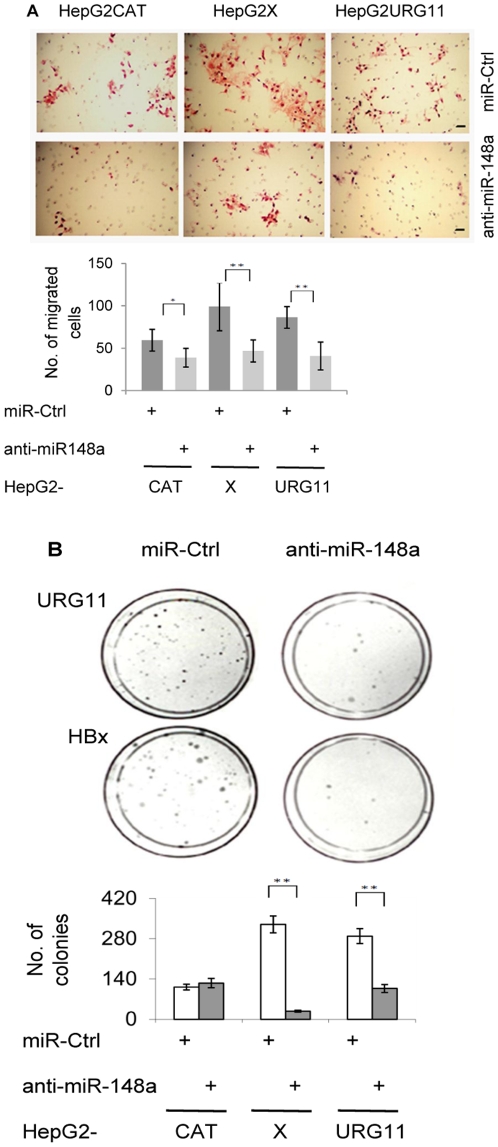
Effect of anti-miR148a on cell migration and anchorage independent growth.(A) Migration of HepG2CAT, HepG2X, and HepG2URG11 cells stably expressing anti-miR-148a or control anti-miR. The top portion of this panel shows the results of a single experiment, while the graphical representation below is the average from 3 independent experiments. The black bar in the photomicrographs is 50um. (B) Summary of soft agar assays for HepG2CAT, HepG2X and HepG2URG11 cells stably expressing anti-miR-148a or control anti-miR. The average number of colonies reported here was from three independent experiments performed in triplicate. *  =  P < 0.05; **  =  P < 0.01 in the Student’s t test.